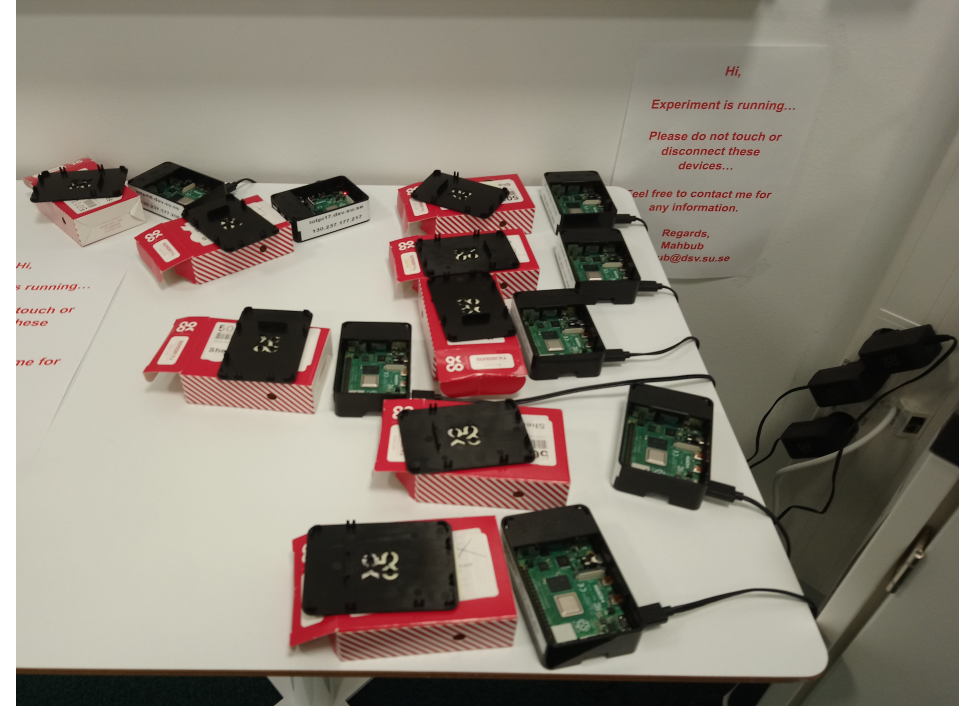
Figure 2. Eight Raspberry Pi devices were used to conduct the